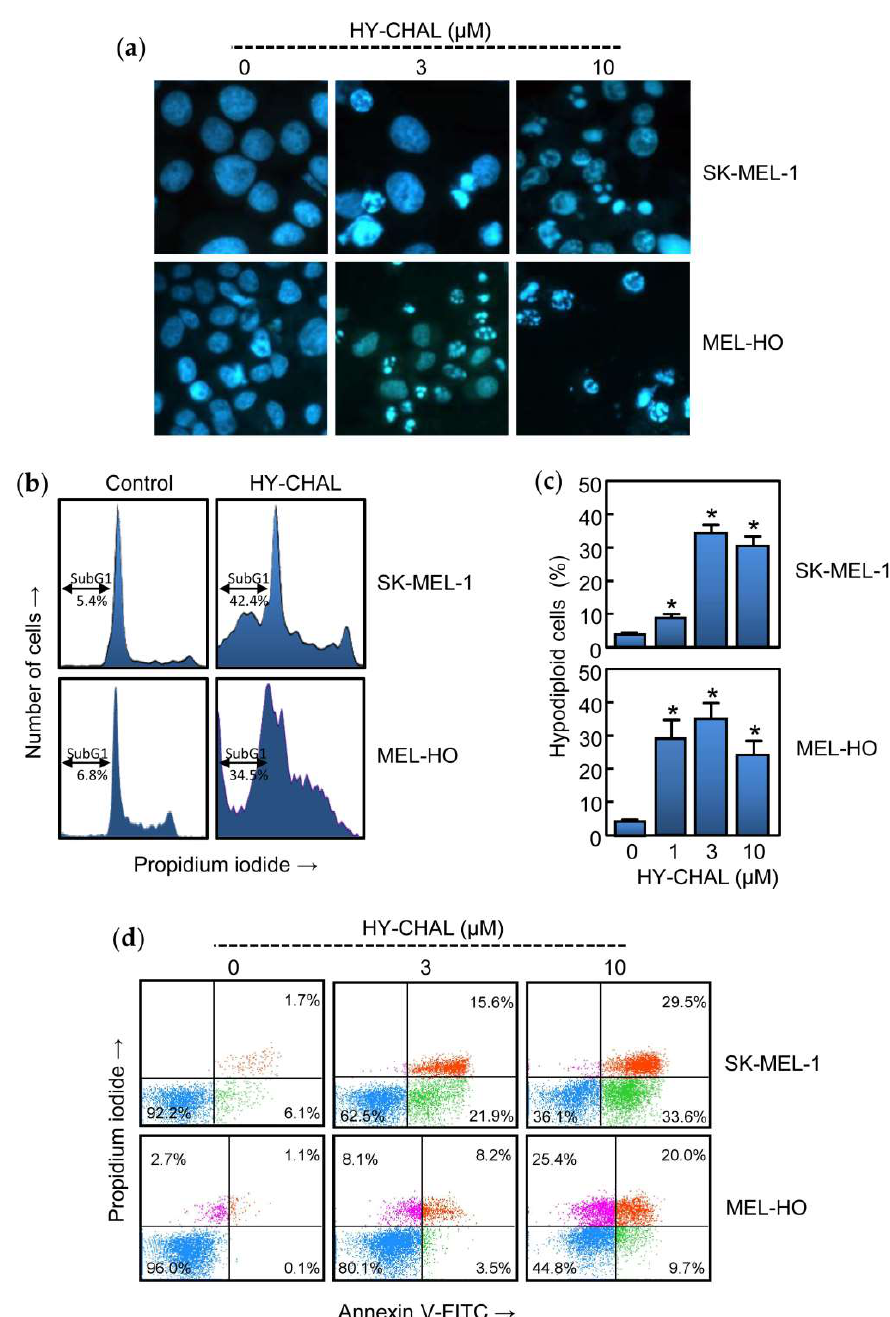
Figure 2. HY-CHAL induced apoptosis in melanoma cells. ( a ) Cells were incubated with increasing concentrations of HY-CHAL for 24 h, stained with bisbenzimide trihydrochloride, and images of representative fields were obtained with a fluorescence microscopy; ( b ) Representative histograms of flow cytometry study. Cells were incubated with 3 µM HY-CHAL, fixed and analyzed by flow cytometry after propidium iodide labeling. Hypodiploid cells (i.e., apoptotic cells) are shown in the region marked with a double edge arrow; ( c ) Cells were treated with increasing concentrations of HY-CHAL and the percentage of hypodiploid cells was determined by flow cytometry. Bars represent the means ± SEs of three independent experiments each were performed in triplicate. * p < 0.05, significantly different from untreated control; ( d ) Cells were incubated with the specified concentrations of HY-CHAL for 24 h, stained with annexin V-FITC and propidium iodide and analyzed by flow cytometry. Data shown are representative of three independent experiments with similar